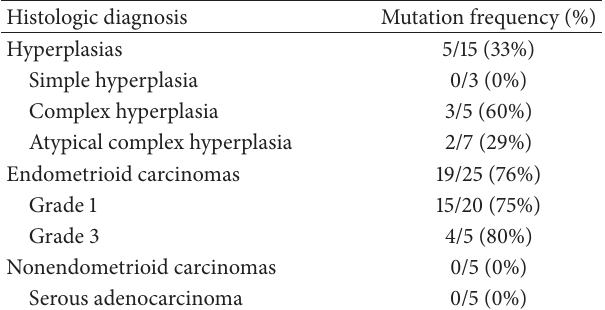
Table 1: Frequency of PTEN mutations in endometrial